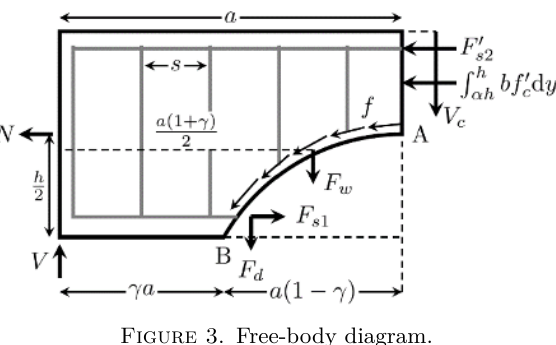
Figure 3. Free-body diagram.